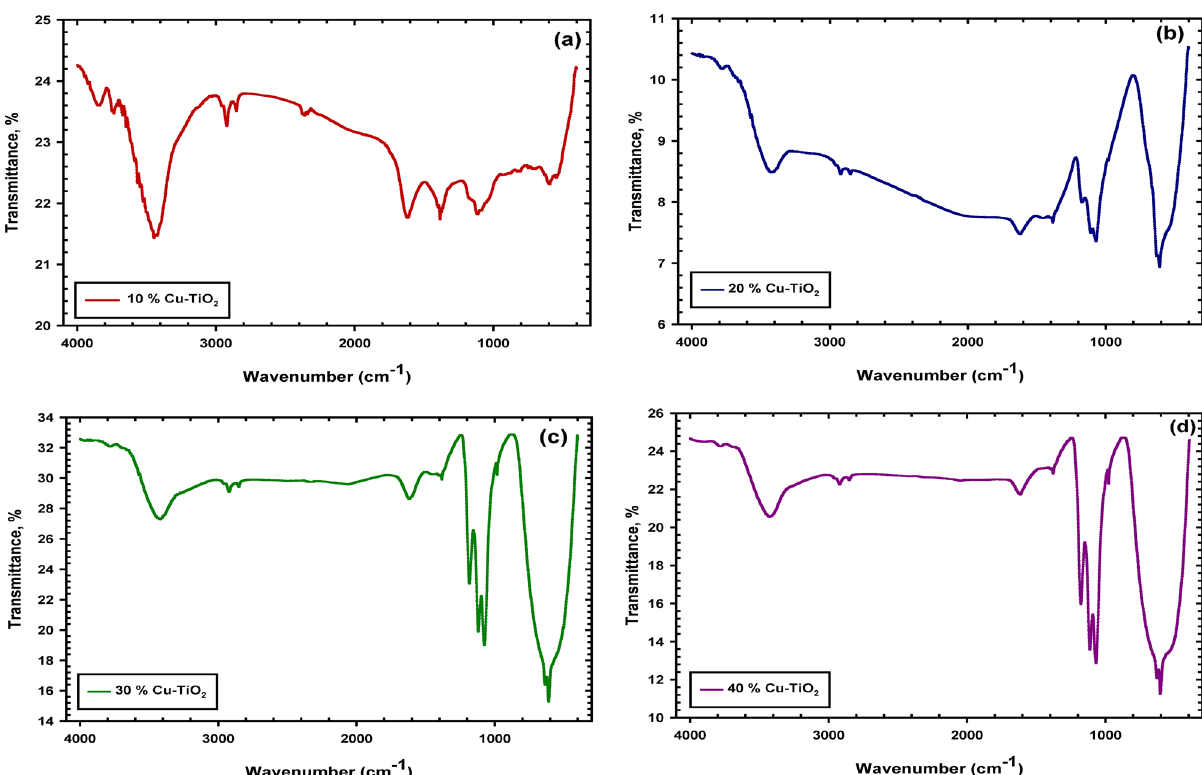
Figure 3. Representative the DRIFTS spectra of Cu–TiO 2 catalyst at various Cu contents 10, 20, 30, and 40 wt.% of TiO 2 . ( a ) Represents Cu + 10 wt.% of TiO 2 ; ( b ) Represents Cu + 20 wt.% of TiO 2 ; ( c ) Represents Cu + 30 wt.% of TiO 2 ; and ( d ) Represents Cu + 40 wt.% of TiO 2 . The peaks refer to absorption bands in spectra, since at 3426 and 1620 cm −1 which are due to OH-stretching and bending vibrations. The Ti–O band was detected between 500 and 900 cm −1 . The mixed oxide (Ti–O–Cu) bonding appeared at 2922 cm −1